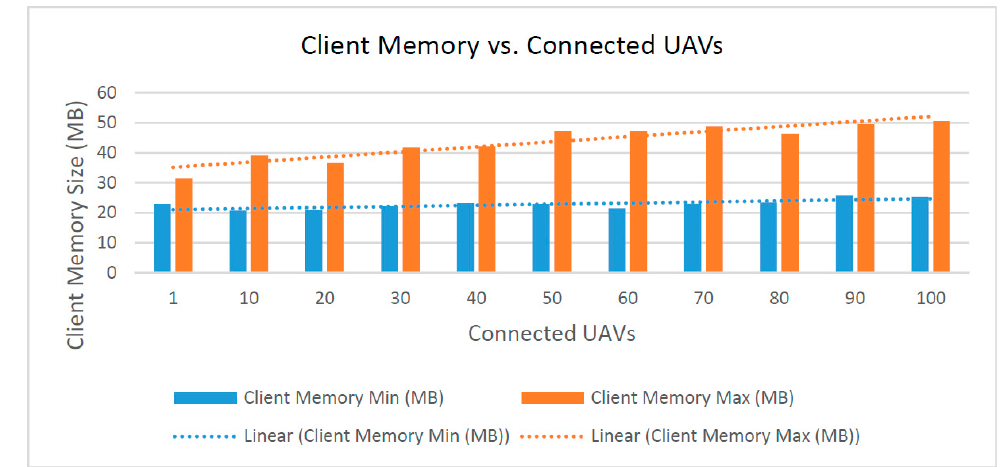
Figure 13. Required memory size on client vs. connected UAVs.